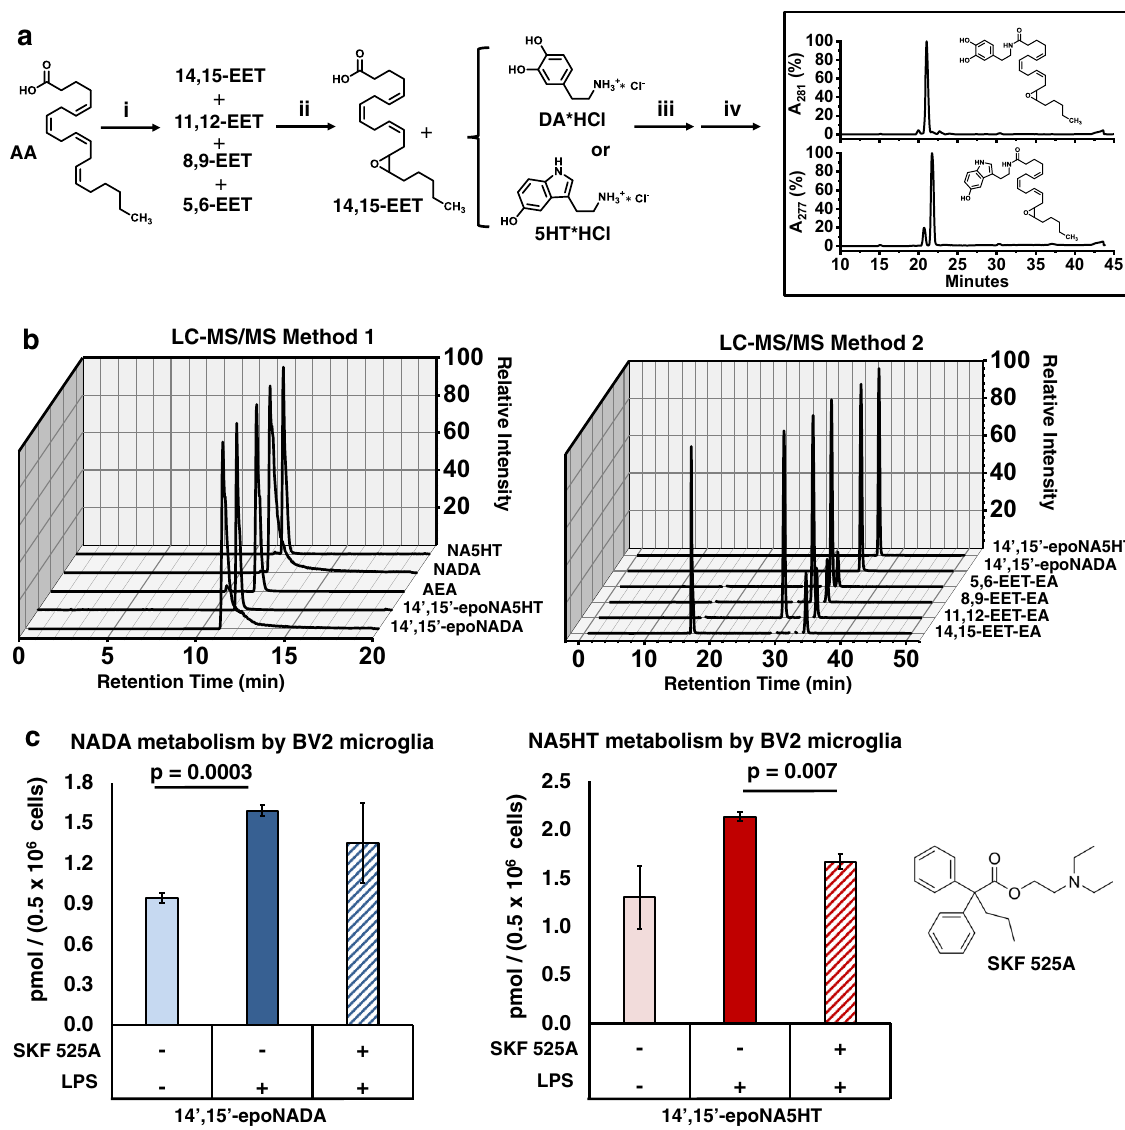
Fig. 2 Targeted lipidomics for measuring eVDs and epoxy-eVDs. a Authentic standards 14 ’ ,15 ’ -epoNADA and 14 ’ ,15 ’ -epoNA5HT were synthesized. (i) m- CPBA, RT, 1 h, MeCN (ii) reverse-phase HPLC purify (iii) EDC, DMAP, DIPEA; ice bath 1 h; RT 8 h; 50:50 DCM:DMF (iv) reverse-phase HPLC purify. b Development of LC-MS/MS method for the separation of NADA, epo-NADA, NA5HT, epo-NA5HT and AEA (Method 1) and the different regioisomers of EET-EAs and epo-NADA and epo-NA5HT (Method 2). AEA m / z 348.3 → m / z 203.2; NADA m / z 440.2 → m / z 287.1; 14 ’ ,15 ’ -epoNADA m / z 456.3 → m / z 137.1; 14 ’ ,15 ’ -epoNA5HT m / z 479.3 → m / z 160.1; NA5HT m / z 463.3 → m / z 287.2; EET-EA m / z 264.2 → m / z 62.0. c NADA and NA5HT metabolism by BV2 microglial cells under lipopolysaccharide (LPS) stimulation in the presence of 1 µ M t-AUCB (sEH inhibitor) and 10 µ M NADA or NA5HT. The experiments. Statistical signi fi cance based on a two-tailed t -test with equal variance. All data can be found in the Source Data fi